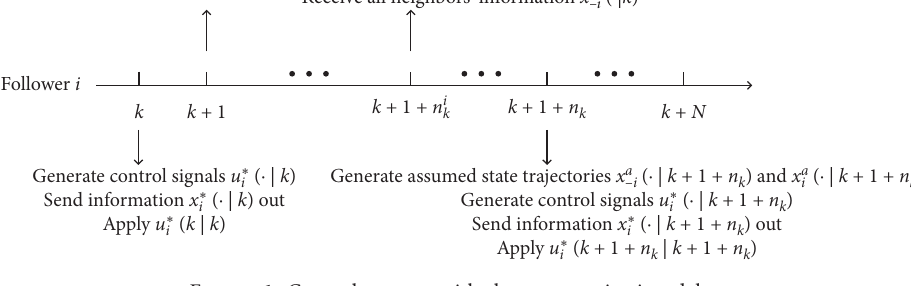
Figure 1: Control process with the communication delays.